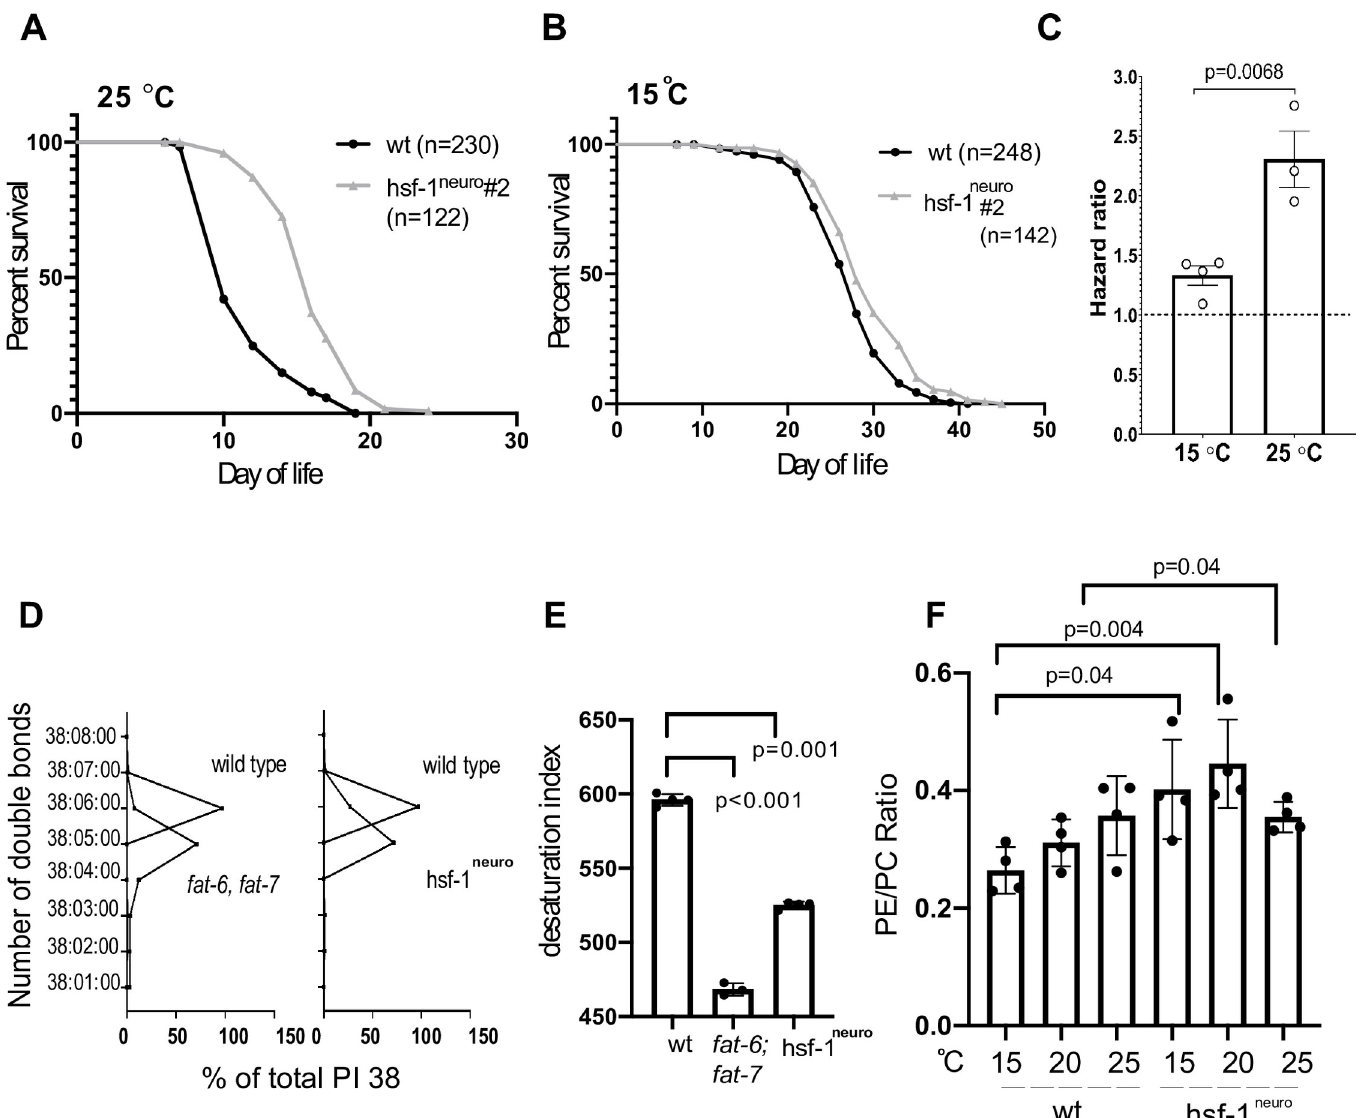
Fig 1. A perceived warmer temperature alters the desaturation of membrane phospholipids in hsf-1 worms, providing an adaptive advantage. (A–C) hsf-1 neuro is beneficial for life span at 25˚C but not at 15˚C. (A) Representative survival curve of WT (N2) and hsf-1 neuro #2 hsf-1 neuro line 2 (AGD1289) raised at 25˚C; wt: 230 deaths, 85 censored. hsf-1 neuro #2 : 122 deaths, 162 censored. Median survival wt: 10 days, hsf-1 neuro #2 : 16 days. Hazard ratio WT/ hsf-1 neuro #2: 2.756, p -value (log-rank test) WT versus hsf-1 neuro #2 < 0.0001. (B) Representative survival curves of wt and hsf-1 neuro #2 raised at 15˚C. wt: 247 deaths, 244 censored. hsf-1 neuro #2 : 77 deaths, 418 censored. Median survival wt: 28 days, hsf-1 neuro #2 : 28 days. Hazard ratio WT/ hsf-1 neuro #2: 1.436. p -Value (log-rank test) wt versus hsf-1 neuro #2 : 0.0011. (C) When considering all biological replicates performed at 25˚C or 15˚C, the risk of death of WT is significantly higher at 25˚C, compared to hsf-1 neuro #2 . Histogram depicting the hazard ratio WT/ hsf-1 neuro #2 for 4 biological replicates at 15˚C and 3 biological replicates at 25˚C. p -Value = 0.0068 (unpaired t test). All data and statistics for the life